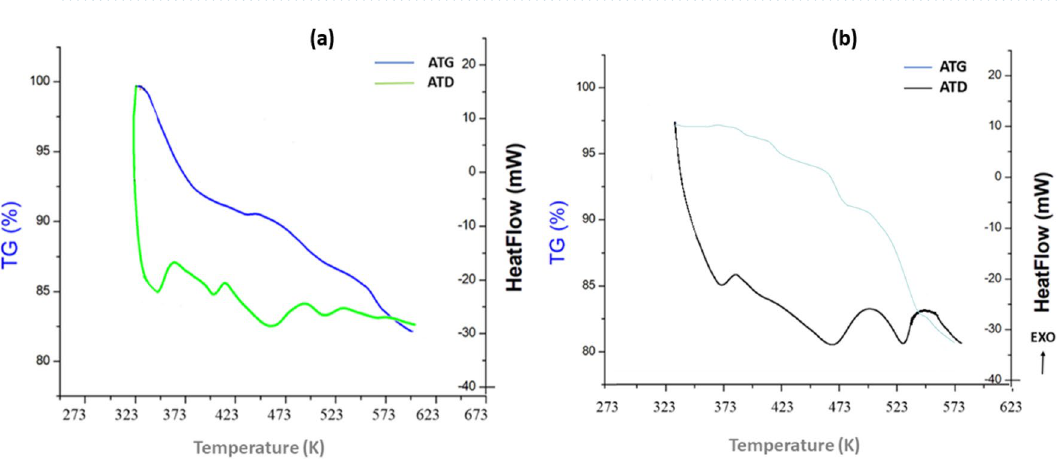
Figure 9. DTA/TG curves of ( a ) {[Co(SCN) 4 ] (C 8 H 12 N) 3 }·Cl and ( b ) {[Co(SCN) 4 ] (C 5 H 11 N 3 ) 3